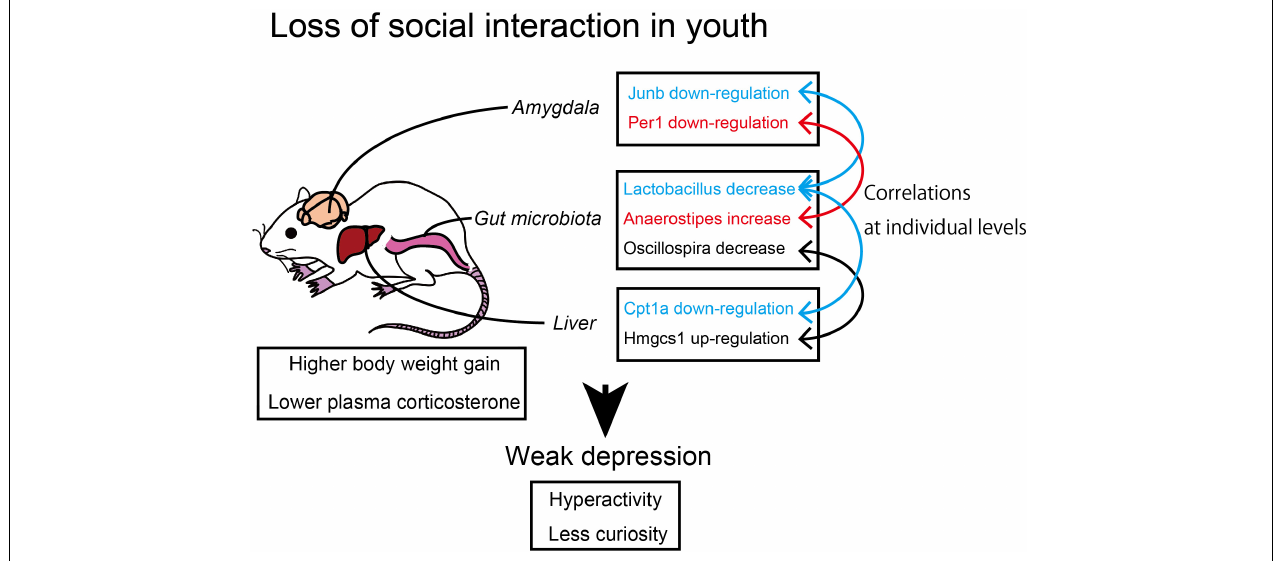
FIGURE 7 | The correlation between microbiome and transcriptome in socially isolated mice. The young mice raised under single housing (SH) condition showed suppressed cyclic adenine monophosphate (cAMP) signaling in the amygdala and suppressed lipolysis in the liver with the coordination of gut bacteria genera.